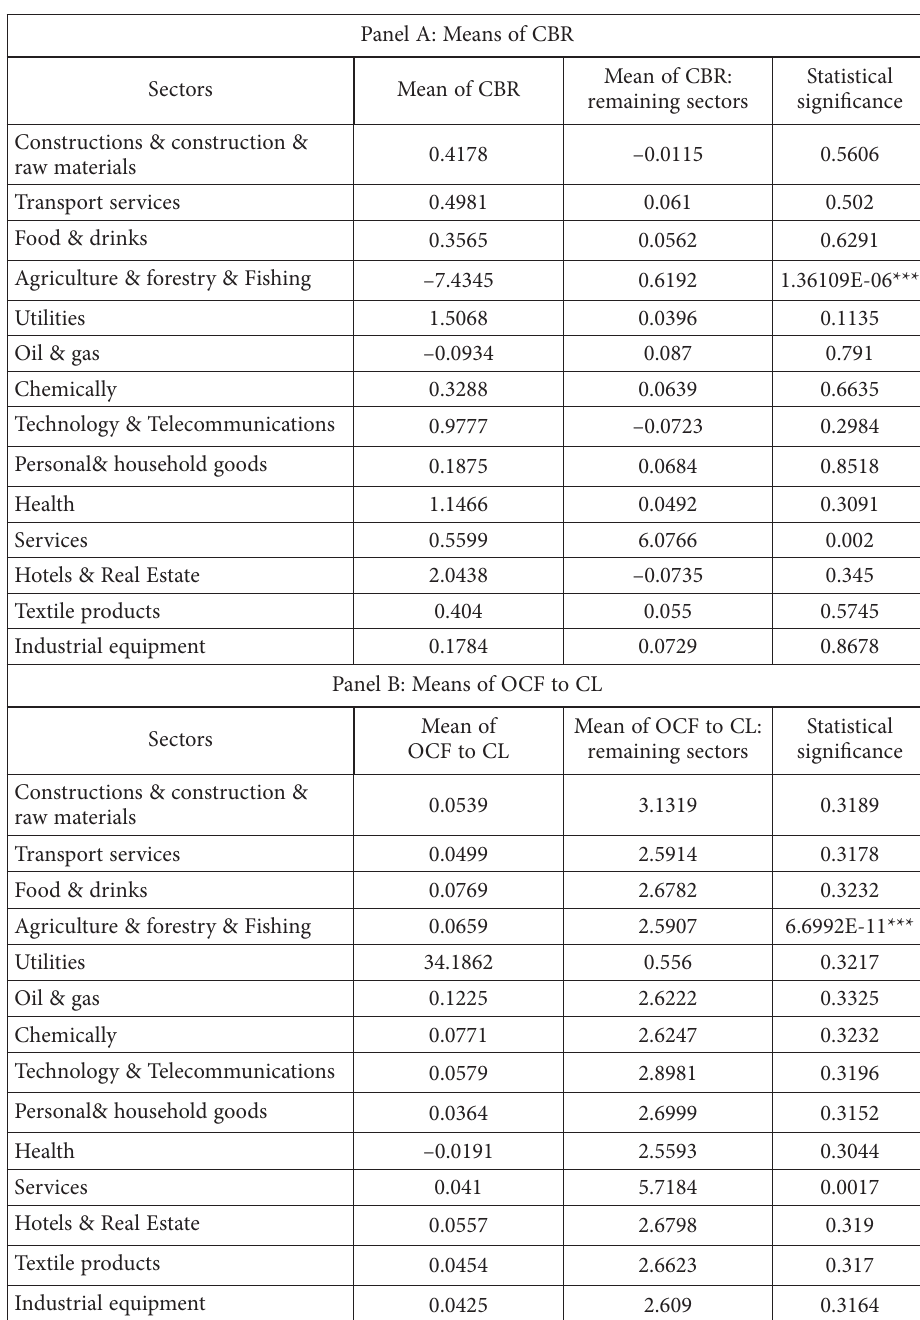
Table 5. Means of CBR, OCF to CL and OCF to TD of firms with quick flexibility in different sectors Panel A: Means of CBR Mean of CBR: Statistical Sectors Mean of CBR remaining sectors